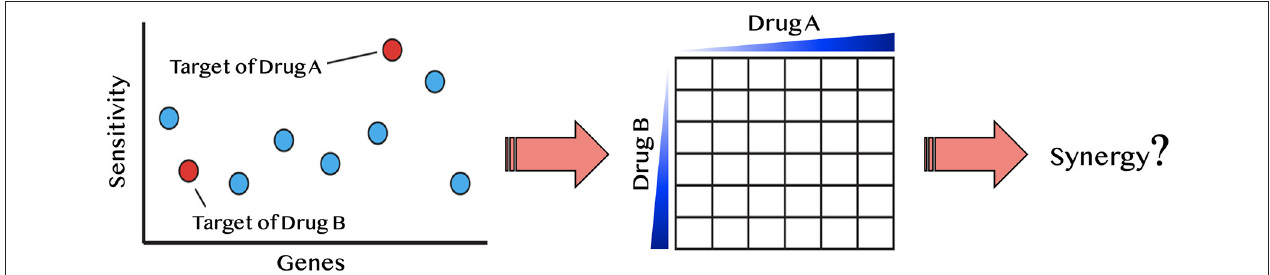
FIGURE 3 | Diagram of synergy prediction method. The HIP–HOP profile for drug A, in which red circles are essential genes and blue are nonessential genes. Genes are listed on the x-axis and sensitivity to drug A is on the y-axis. The most sensitive strain in this example is the target of drug A. However, another essential gene also displays sensitivity to drug A. This gene is the known drug-target of drug B. Using the synergy prediction method, drug A and drug B would be predicted to be synergistic. By testing them in a drug dosage matrix, one can determine if this assumption is